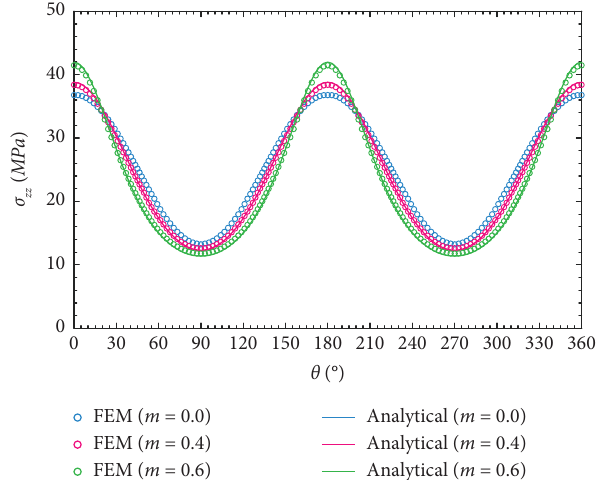
Figure 6: Vertical stress in the borehole wall for diferent values of m .